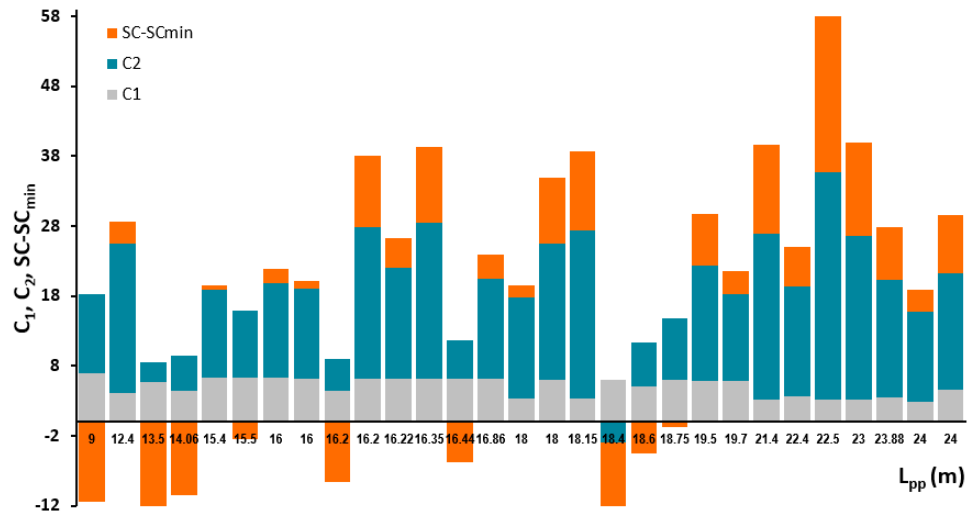
Figure 10. Evolution of C 1 , C 2 , and ( SC ‒ SC min ) coefficients as a function of vessel length ( L pp ) as a new criterion.